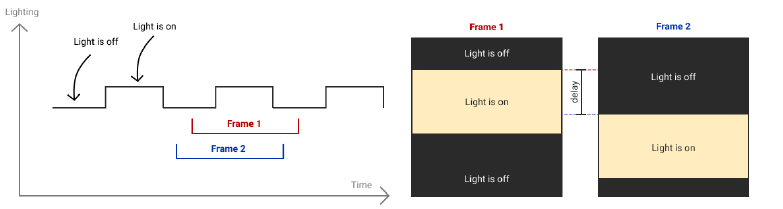
Figure 13. Light source experiment setup.